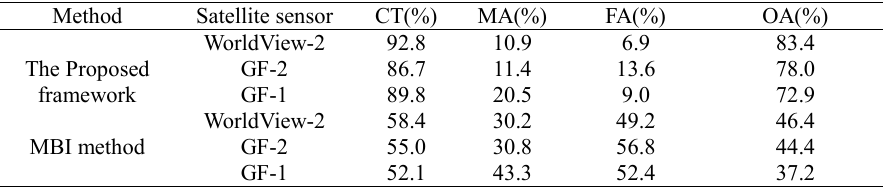
Table 2 Accuracy assessment of building extraction